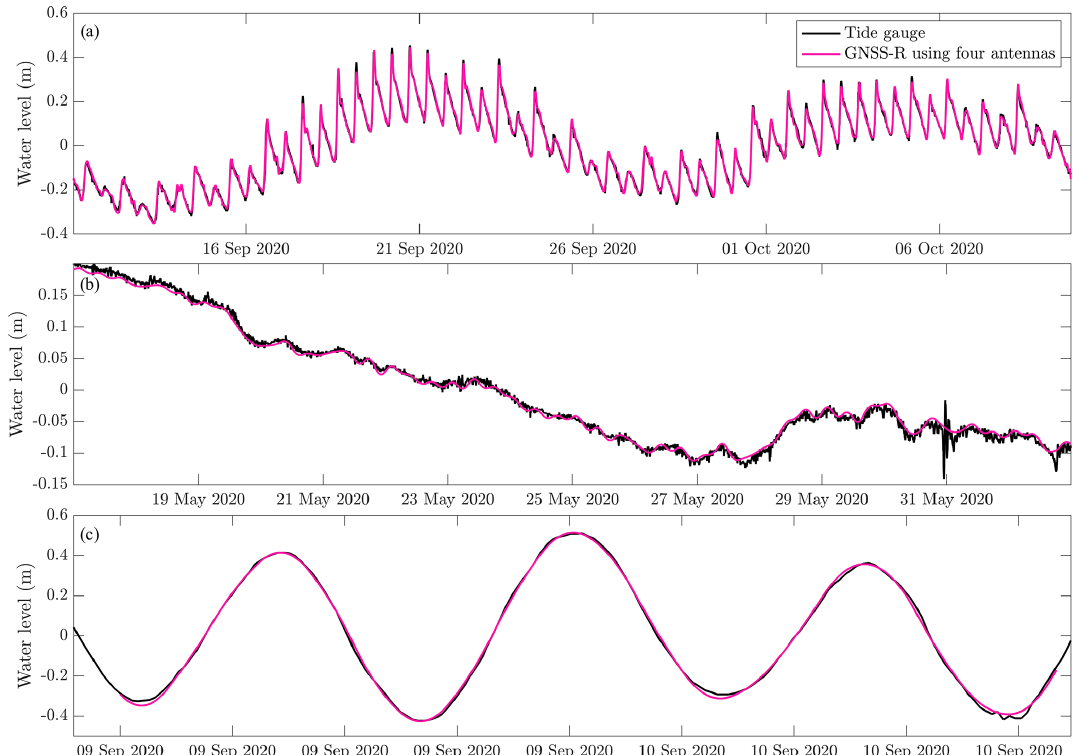
Figure 4. A comparison of GNSS-R and tide gauge measurements at (a) Trois-Rivières, (b) Sainte-Anne-de-Bellevue and (c) Piermont. The mean of each time series is removed before plotting.